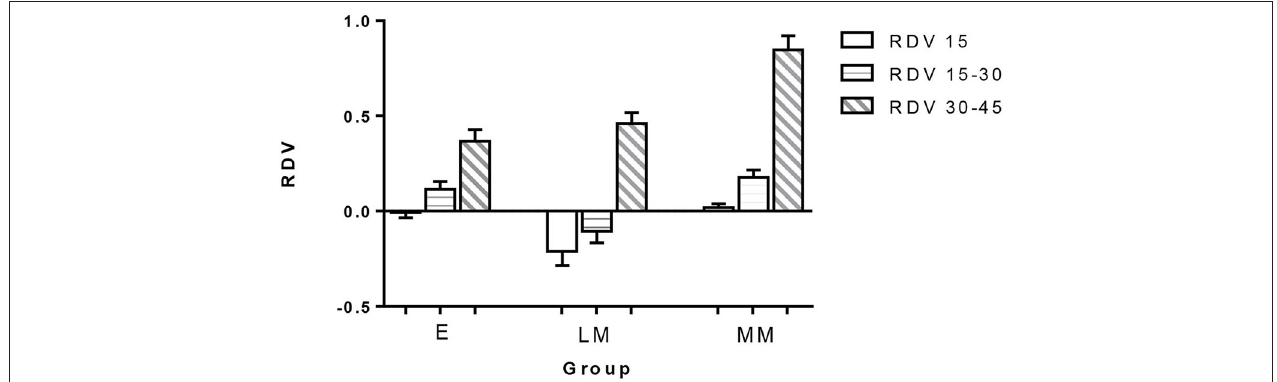
FIGURE 5 | The retinal relative diopter (RDV) values of different peripheral retinal ranges in three groups. In the range of RDV-15, the differences between groups E vs. LM and groups E vs . MM were statistically significant. In the range of RDV 15–30, the differences between groups E vs. LM and groups LM vs . MM were statistically significant. In the range of RDV 30–45, the difference between group E vs. LM and group E vs. MM was statistically significant ( P < 0.05).